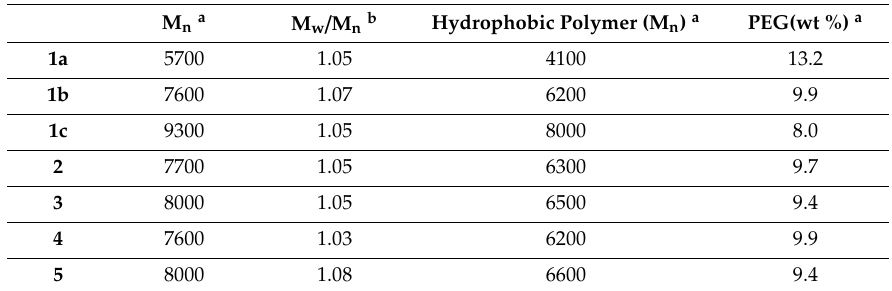
Figure 2. Chemical structures of photocleavable amphiphilic diblock copolymers used in this study. The hydrophobic and hydrophilic segments are shown in red and blue, respectively. The terminal end groups produced at the inner and outer interfaces of the polymersomes after photolysis are shown on the right. Table 1. Characterization of photocleavable diblock